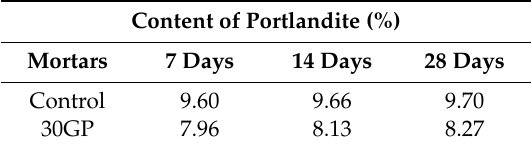
Table 3. Content of portlandite in CEM I and GP pastes.